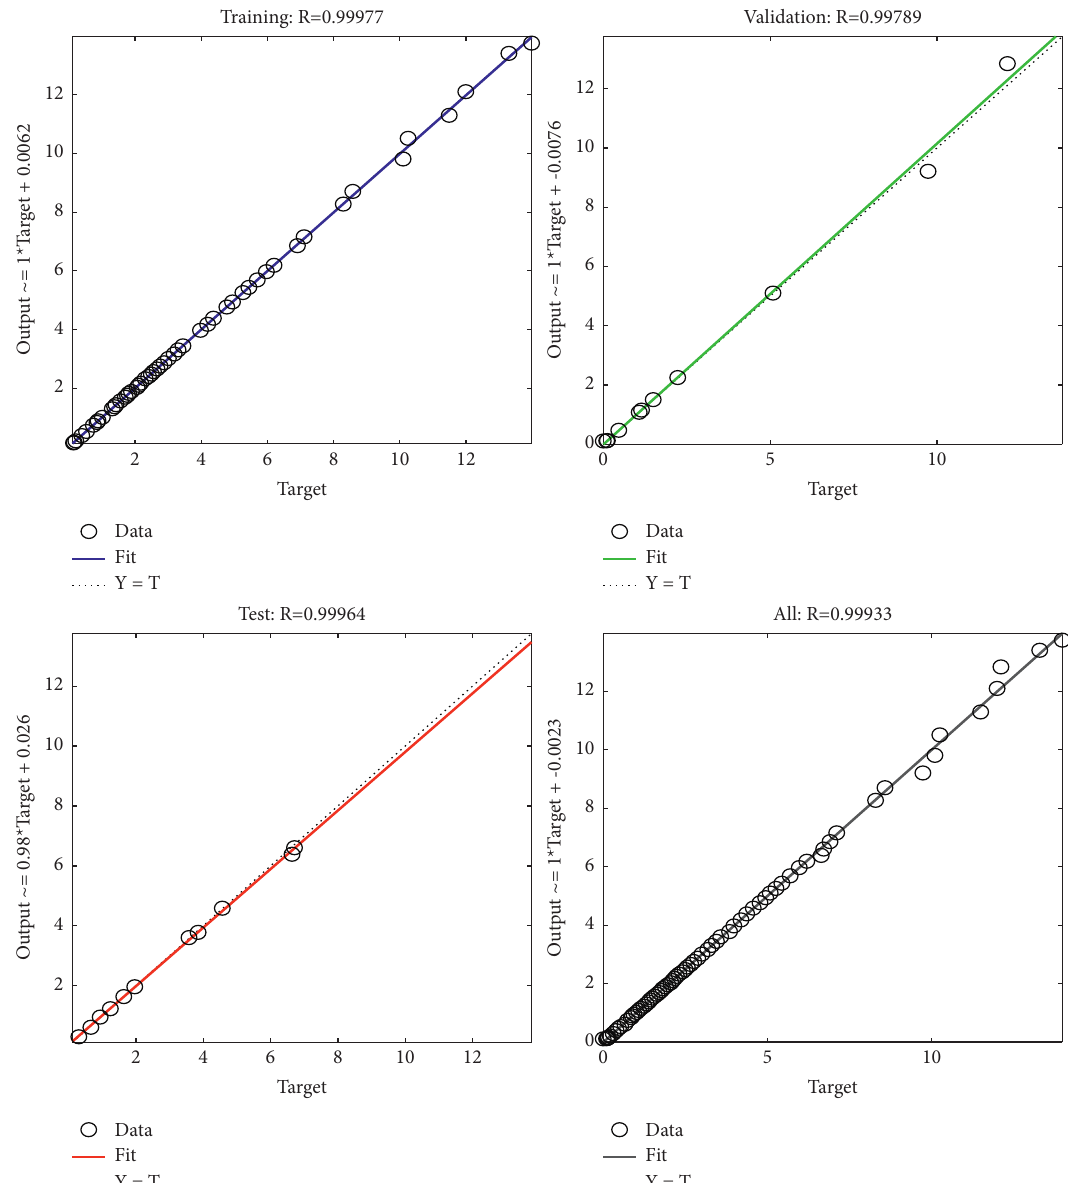
Figure 11: Neural network training regression analysis (optimal performance at 50 neurons in the hidden layer for Scheme C). Predicted vs. Actual